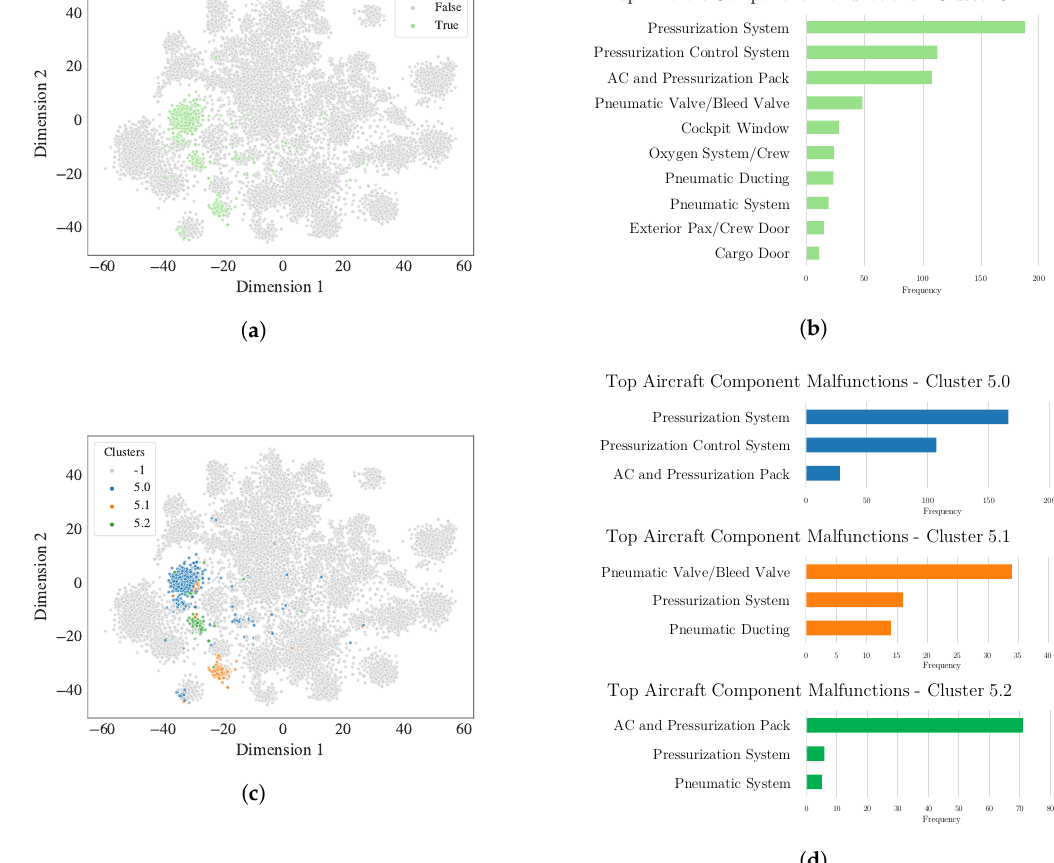
Figure 5. Highlight of cluster 5 and its sub-clusters, including most common aircraft component malfunction metadata plots. ( a ) Highlight of Cluster 5. ( b ) Cluster 5 Aircraft Component. ( c ) Highlight of Cluster 5 Sub-Clusters. ( d ) Sub-Cluster Aircraft